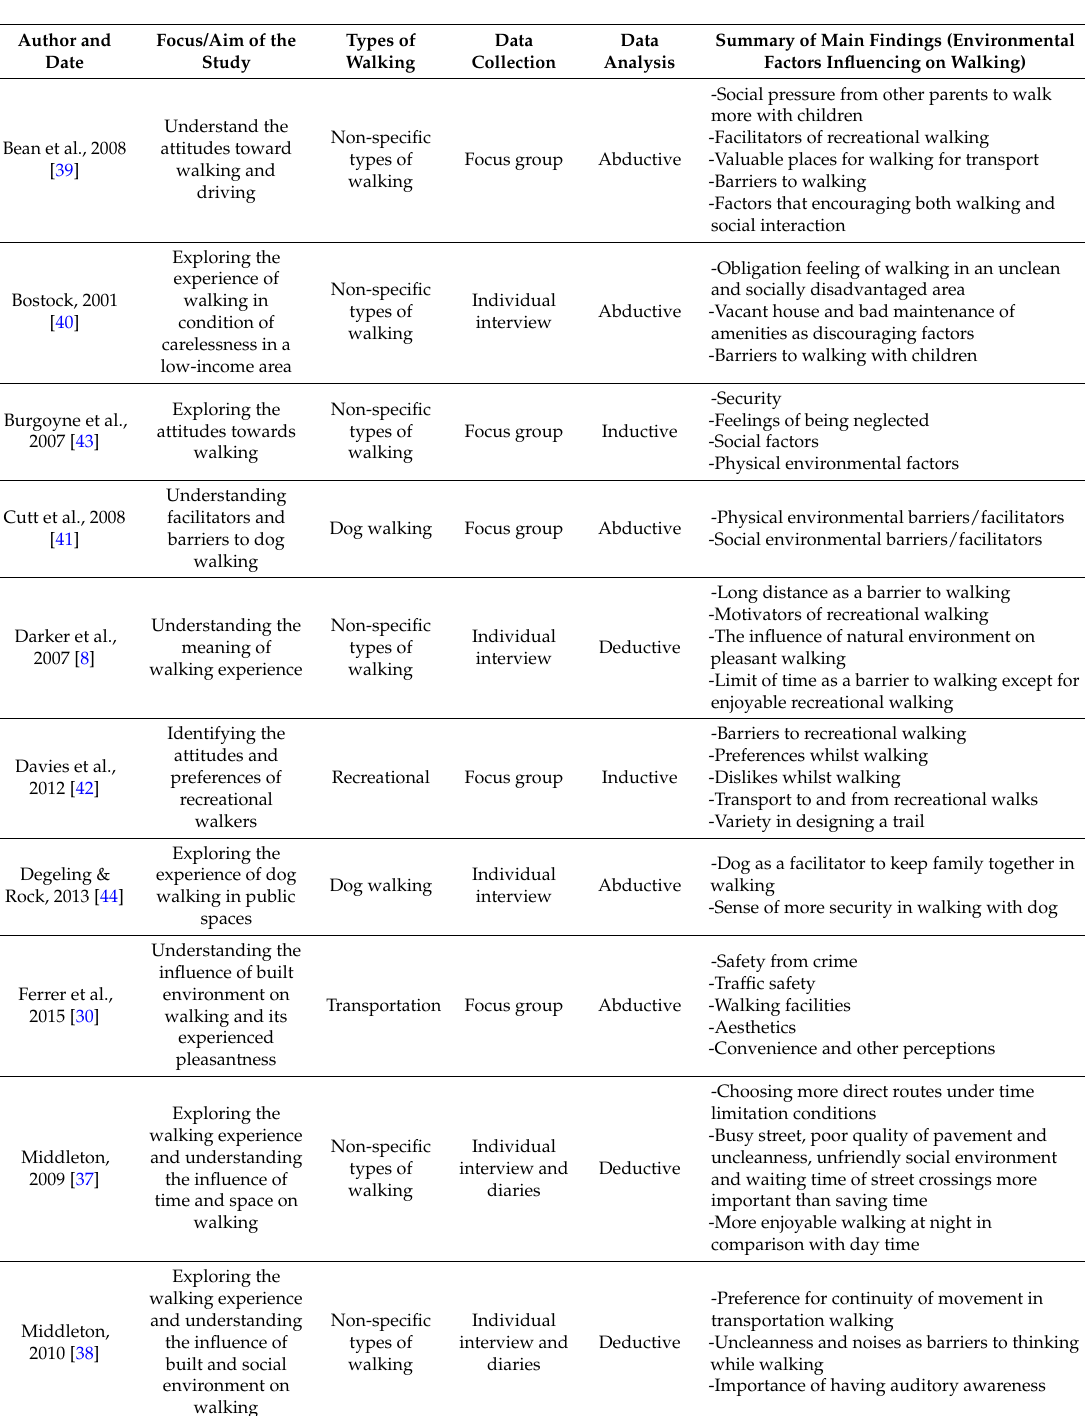
Table 2. Features and summary of main findings of included